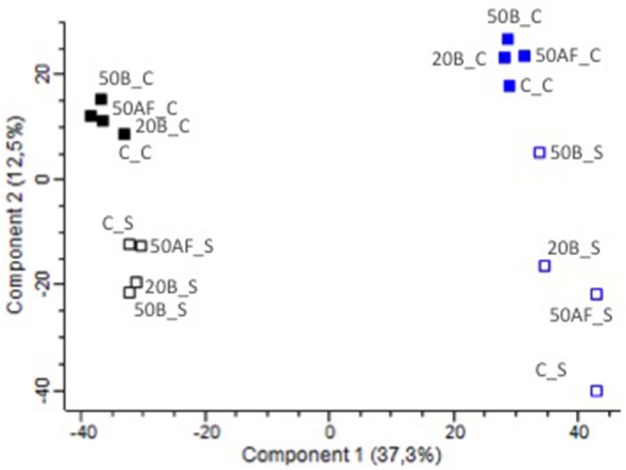
PCA plot of untargeted FT-ICR-MS analysis in negative mode of wines from 2008 (in blue) to 2009 (in black) vintages, treated with GSH after alcoholic fermentation (50AF) or at bottling (20B; 50B) and bottled with screwcap (C) or synthetic cork (S).